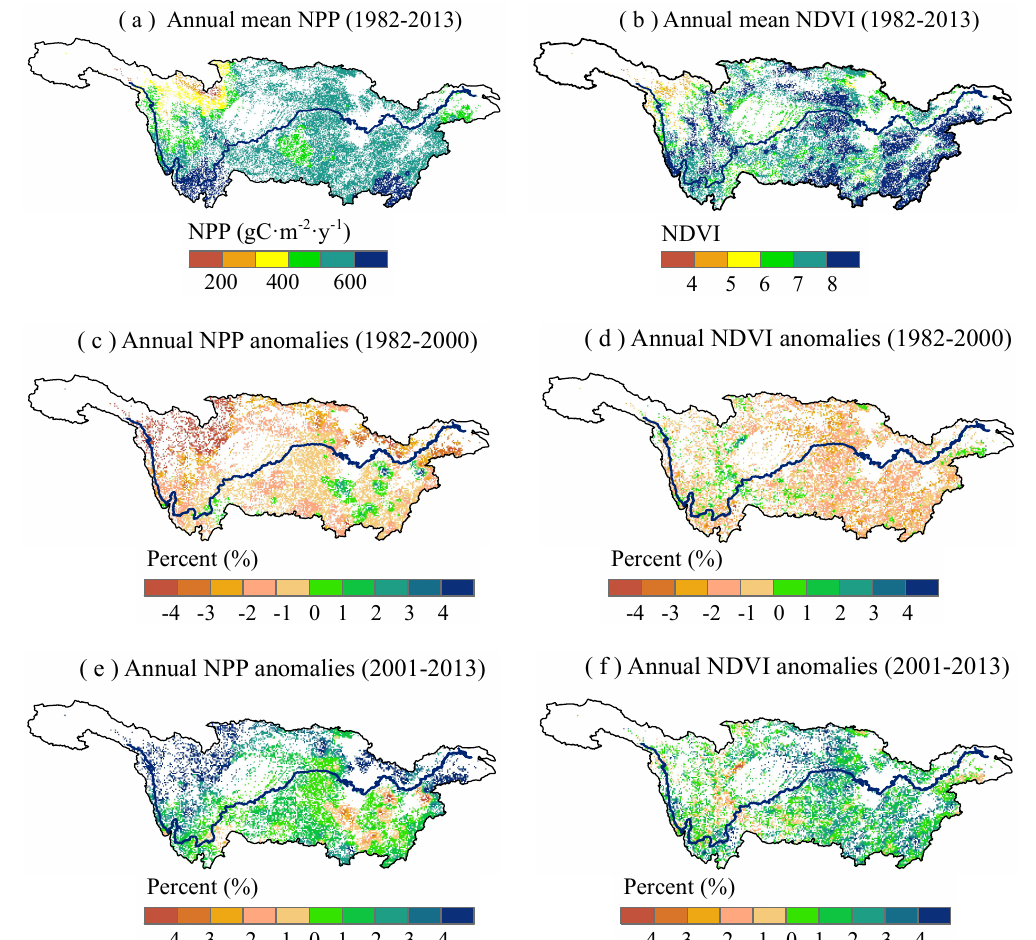
Figure 3. Comparison of the annual mean forest NPP and NDVI in the Yangtze River basin during the periods of 1982–2000 and 2001–2013.